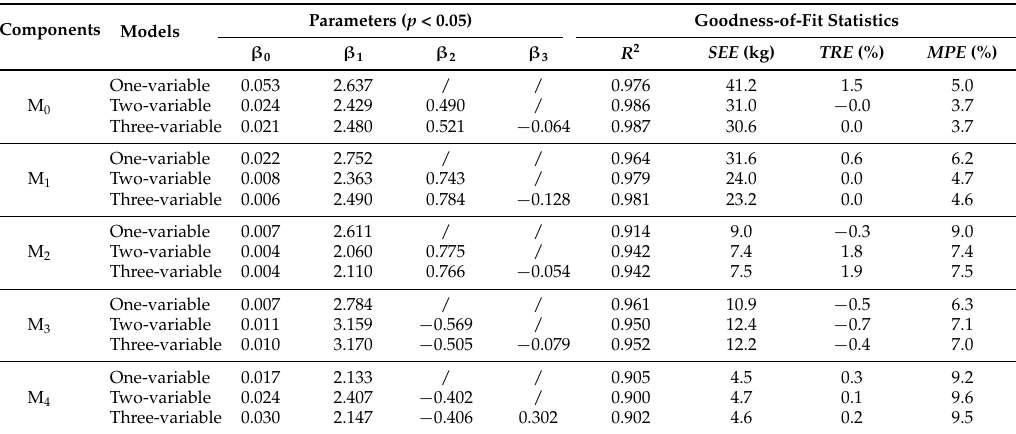
Table 2. Parameters and goodness-of-fit statistics for the biomass of different components estimated for an individual tree ( n = 80).